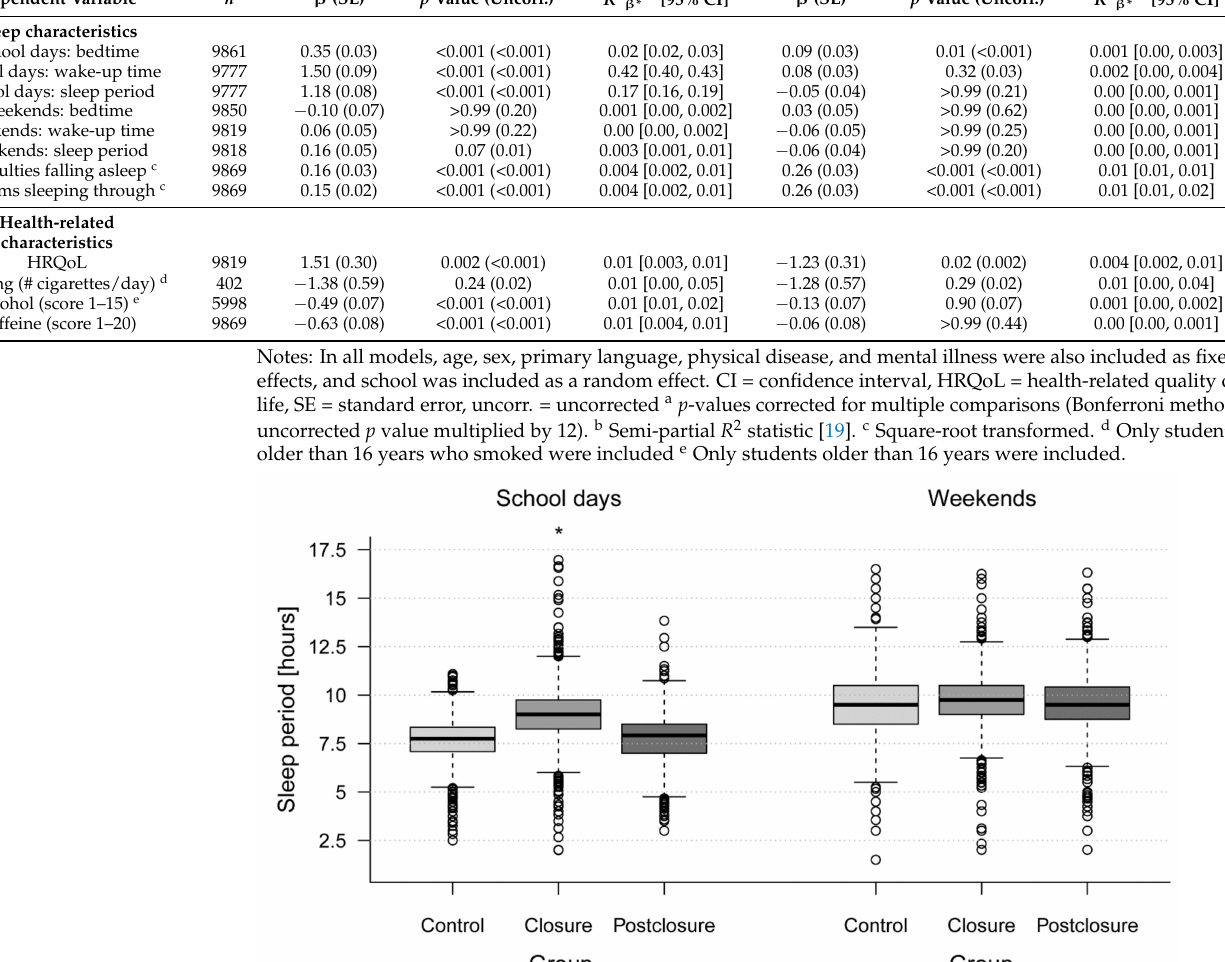
Table 1. Regression coefficients of the sample main effects in models with different dependent variables. Closure vs. Control Sample